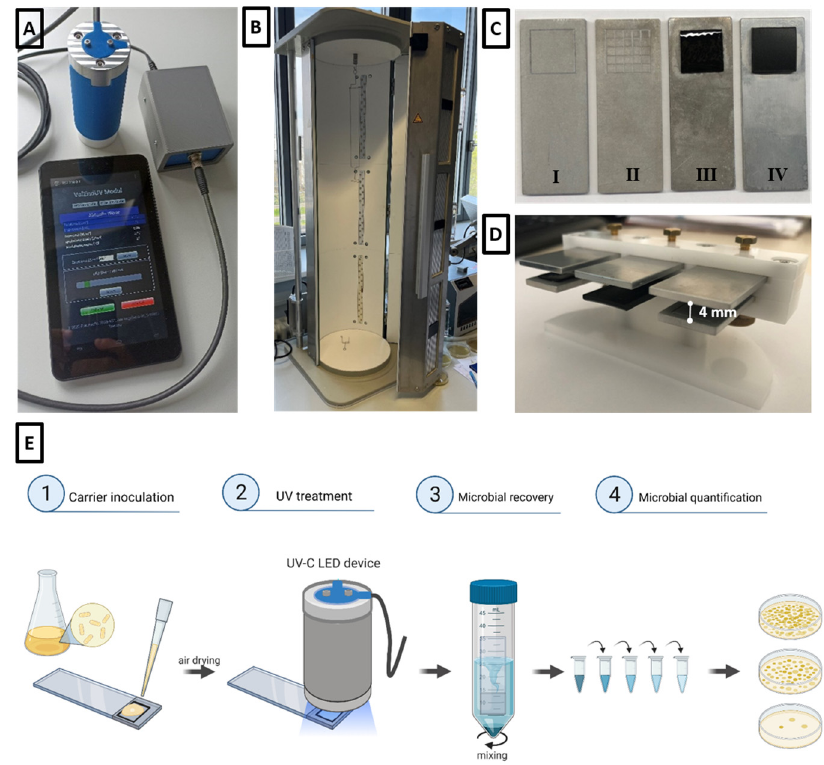
Figure 1. ( A ) Collimated-beam UV-C LED device with measurement and control units. ( B ) UV-C LED device for the irradiation of endoscopes with a cylindrical irradiation chamber. ( C ) Test carrier with test areas made of different materials. (I) Sandblasted aluminum smooth, (II) sandblasted aluminum textured, (III) elastomer and (IV) hard plastic. ( D ) Set-up for testing the influence of shading on UV-C efficiency. ( E ) Schematic diagram of the experimental setup and the different steps of the test procedure. Created with Biorender.com.